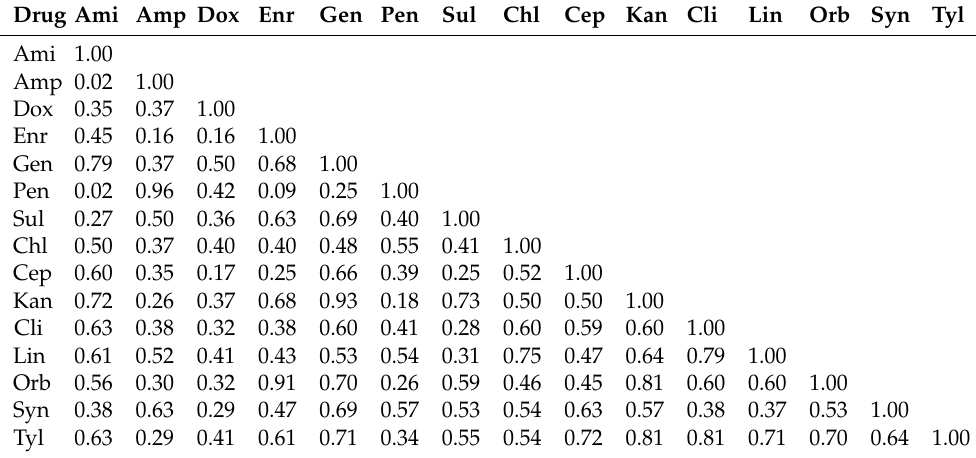
Strong correlations were observed between efficacy profiles of the following antimi- crobials: amikacin vs. gentamycin ( r = 0.79), amikacin vs. kanamycin ( r = 0.72), kanamycin vs. gentamycin ( r = 0.93), ampicillin vs. penicillin ( r = 0.96), enrofloxacin vs. orbifloxacin ( r = 0.91), and lincospectin vs. clindamycin ( r = 0.79) (Table 2). Table 2. Tetrachronic correlations of the efficacy of 15 antimicrobial agents against Staphylococcus isolates at a veterinary academic hospital in South Africa.